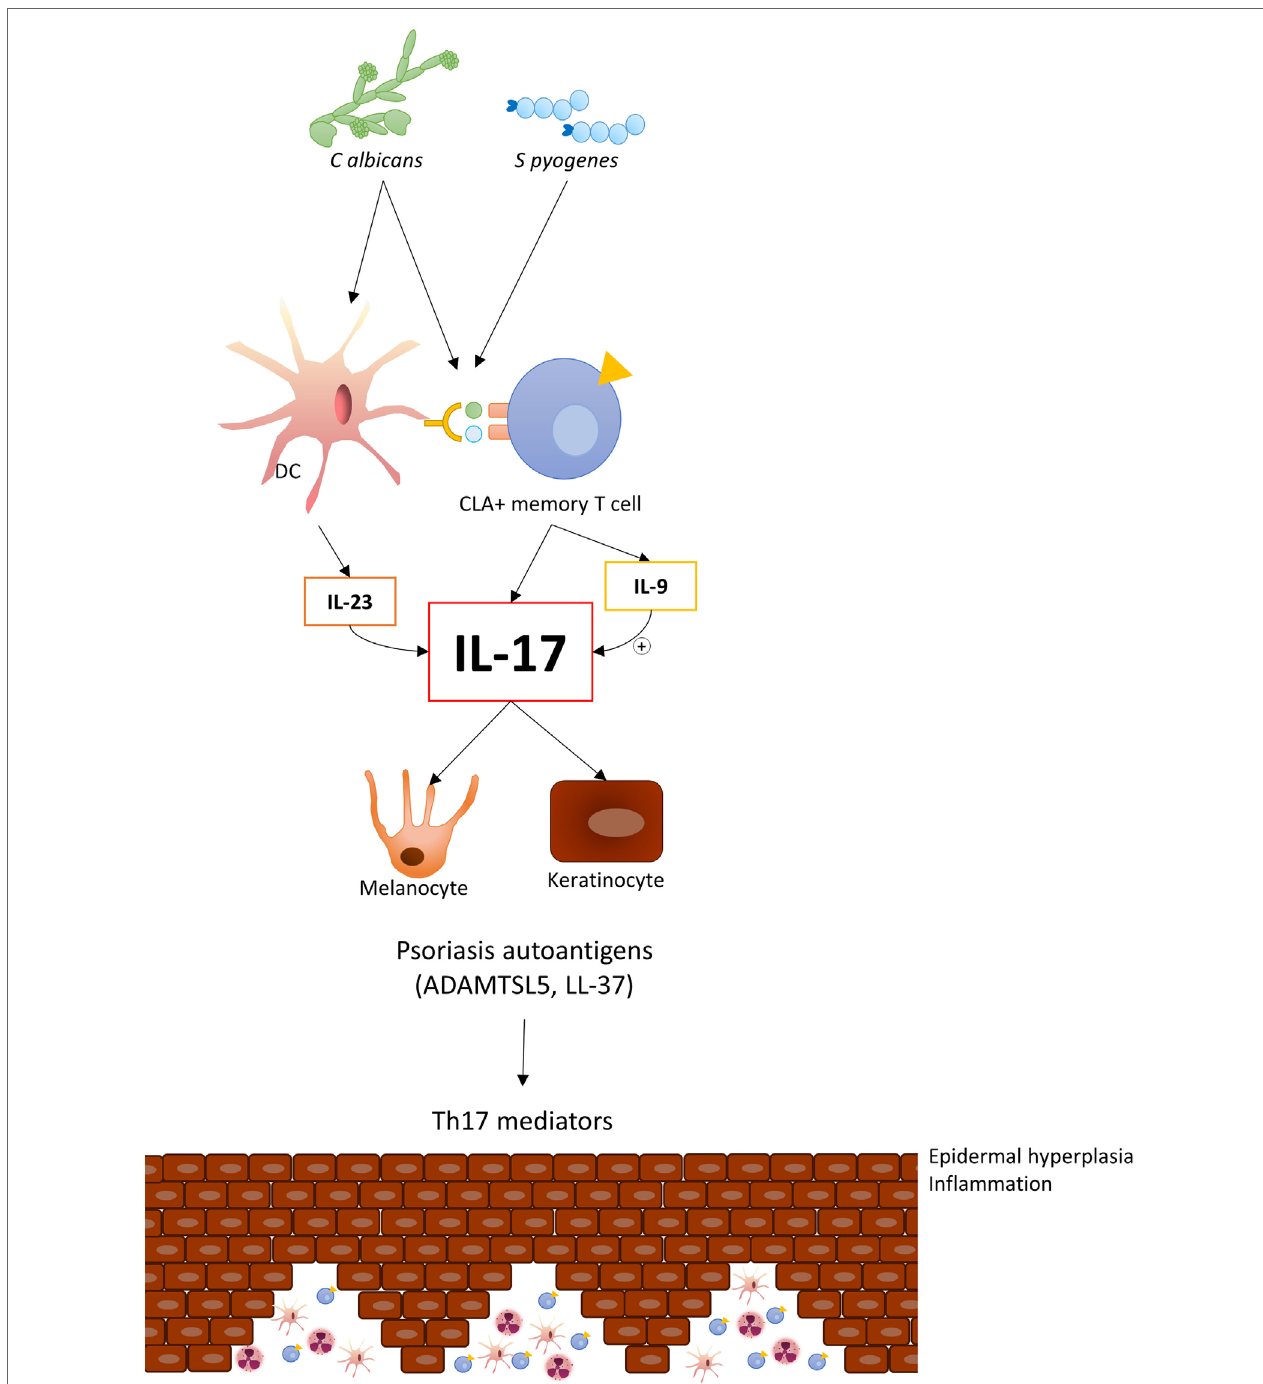
FiGURe 1 | Candida albicans and Streptococcus pyogenes induce IL-17 response in circulating CLA + T cells in psoriasis, thereby indicating an established adaptive immune response to these microorganisms in this disease. Upon migration to cutaneous lesions, these cells react with those microbes and locally trigger IL-17 and IL-9 production, which will contribute to inducing psoriasis autoantigens.